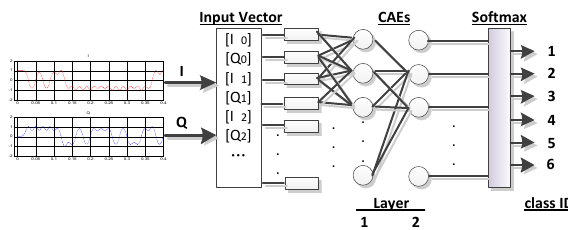
Figure 4. Structure of a modulation classifier constructed using convolutional autoencoders (CAEs) and Softmax. Table 2. Parameters of the training modulation classifier.